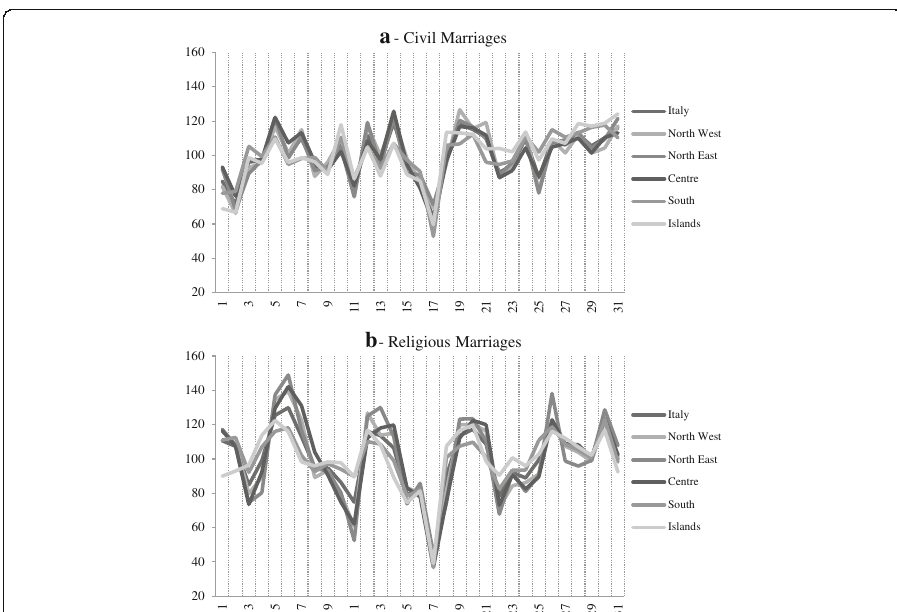
Fig. 1 a , b The effect of the superstition of the 17th day on marriages. Italy and macro-areas, 2007 –